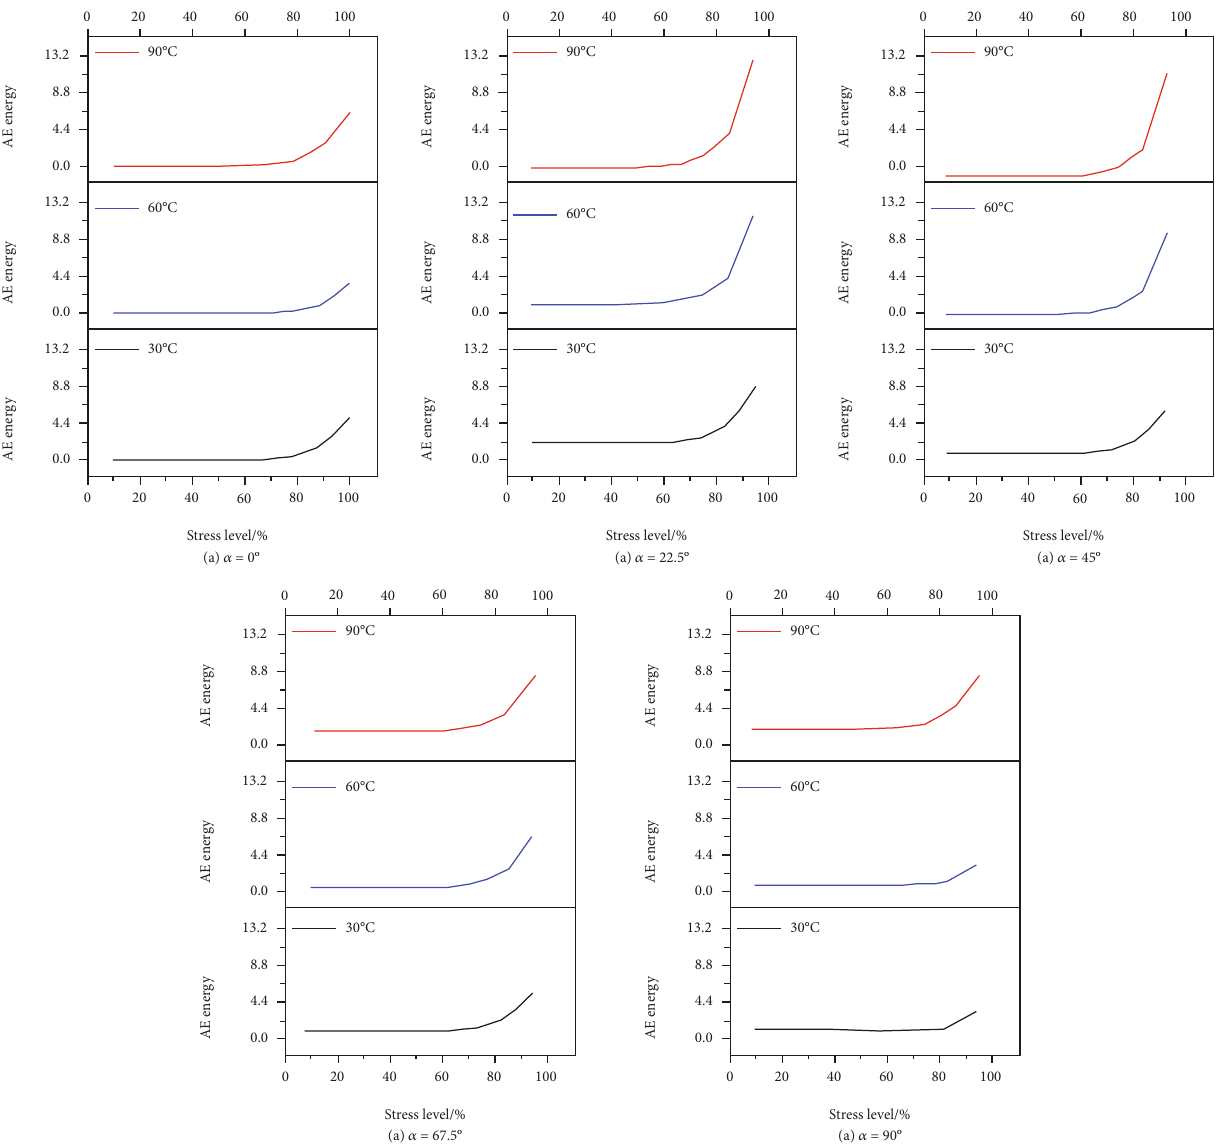
Figure 9: Plot of AE energy versus temperature and stress